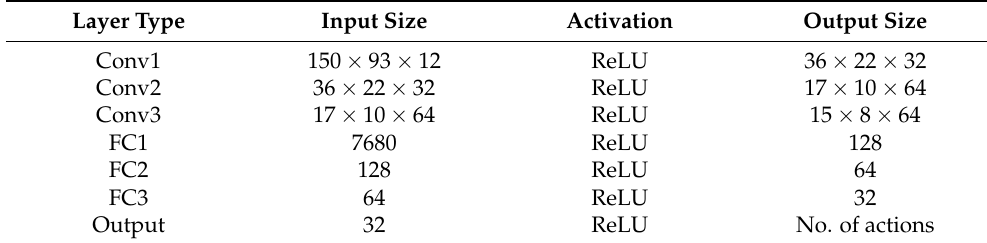
Table 3. DQN model architecture details.